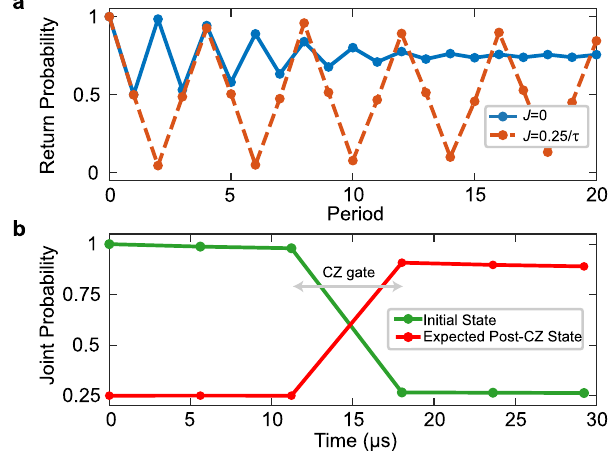
Fig. 5 Preserving and generating entangled states. a Return probability for the singlet state of an ST qubit de fi ned on sites 3 and 4 of an L = 6 spin (cid:1) (cid:3) (cid:1) . b Two- chain. The two remaining ST qubits are initialized in the state "# qubit probabilities before and after the execution of a two-qubit CZ gate, using the modi fi ed DTC protocol (for a chain of length L = 4). The initial (cid:1) (cid:3) (cid:1) state of ST qubit 1 is the triplet T and of qubit 2 is the singlet. The x 0 coordinate of each point is the total time of all the pulse sequences. The y coordinate of each point is the joint two-qubit probability. The “ expected post-CZ state'' is an entangled state of the two ST qubits. The results in both panels are averaged over 4096